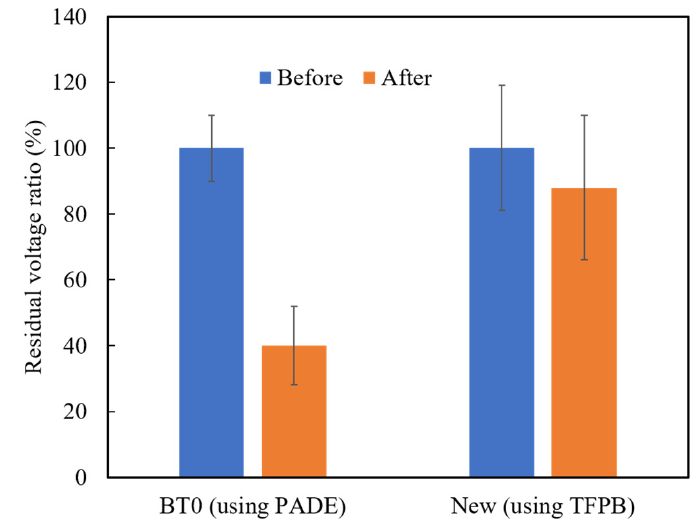
Figure 11. Residual voltage ratios of the BT0 and new TFPB-NPOE sensor. The blue columns represent the residual voltage ratio before the accelerated deterioration process. The orange columns represent the residual voltage ratio after the accelerated deterioration process. The results are expressed as means ± SD ( n = 20, 4 membranes × 5 times).